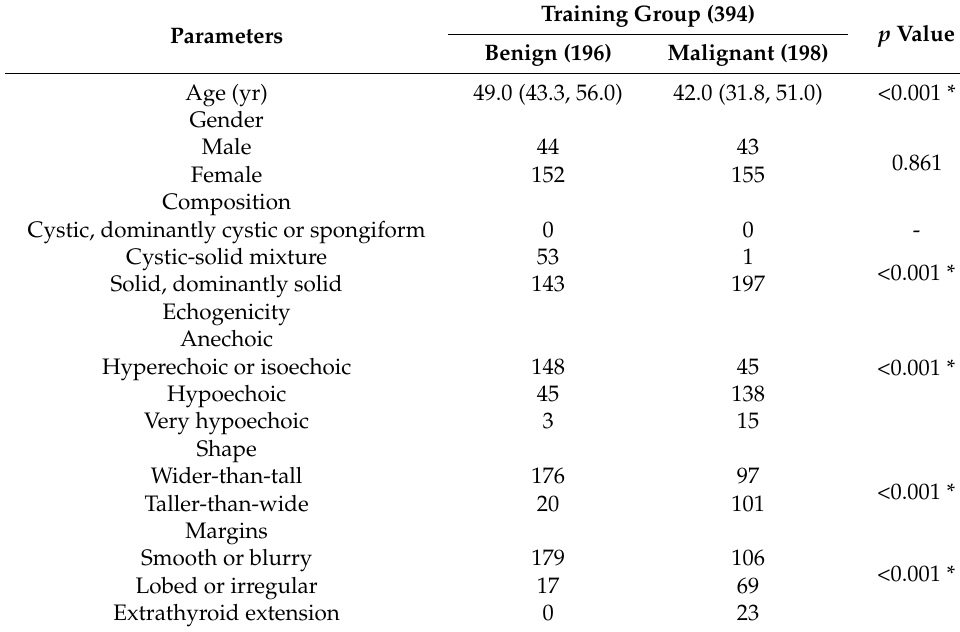
Table 2. Parameters of patients in benign and malignant TNs included in the training